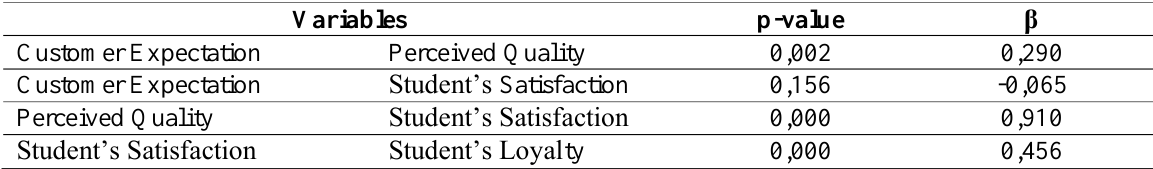
Statistic test of correlations of Customer Expectation, Perceived Quality,